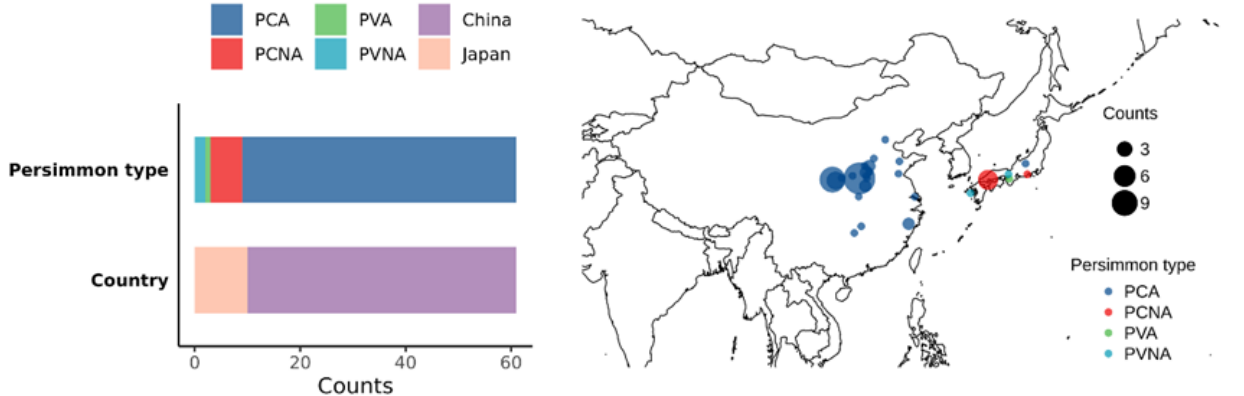
Figure 1. Types and origins of the materials evaluated in this study.